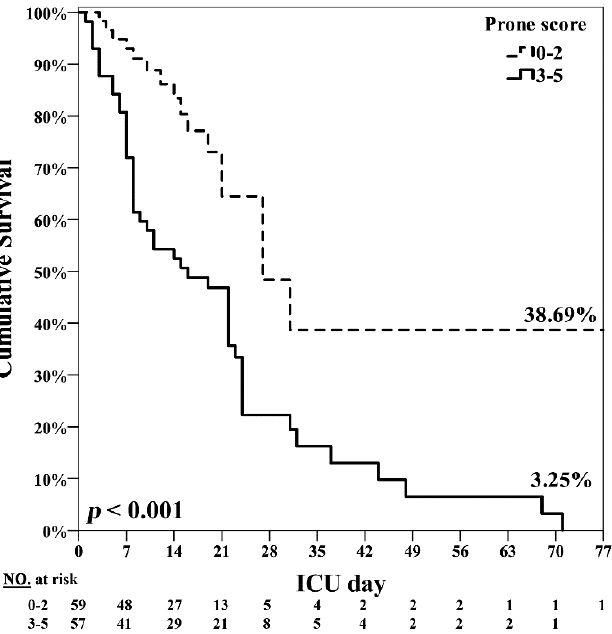
Figure 3. Prone score ≥ 3 was significantly associated with higher mortality in patients with severe ARDS received prone positioning therapy. p <